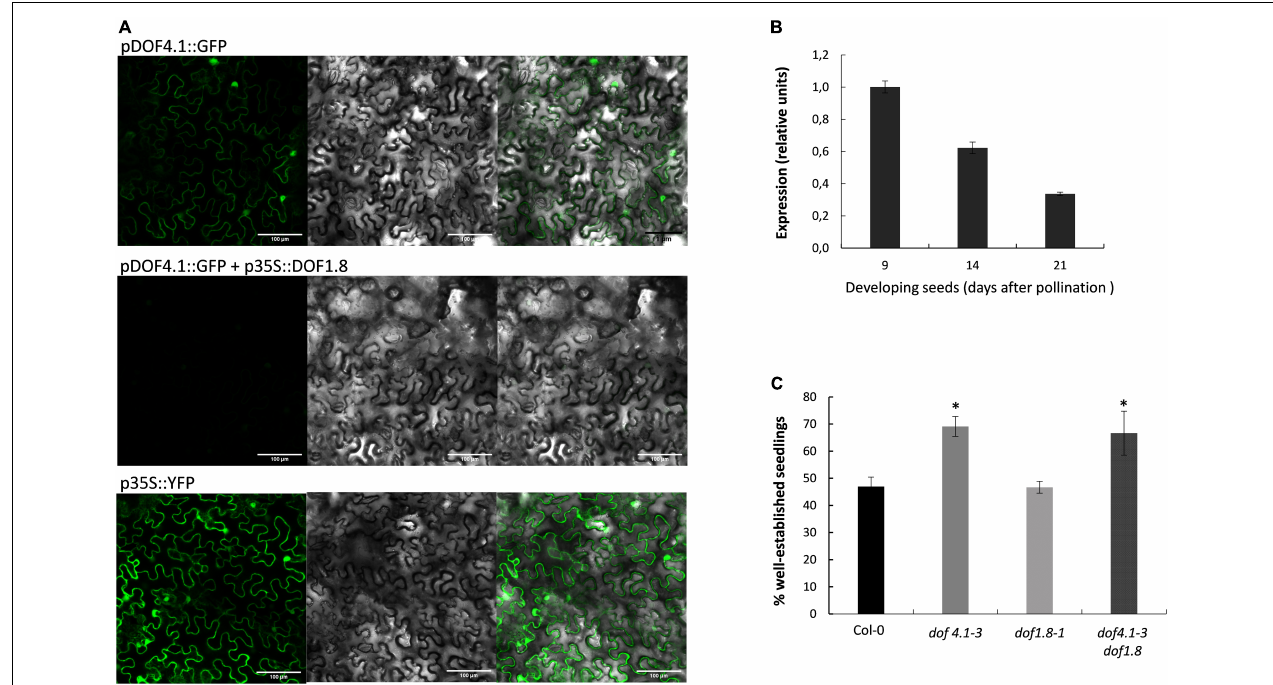
FIGURE 5 | DOF1.8 transcription factor represses DOF4.1. (A) Representative images showing the transient expression of pDOF4.1:GFP in Nicotiana benthamiana leaves 5 days after agroinfiltration in the absence (upper panel) or in the presence (middle panel) of p35S:DOF1.8 . The lower panel shows the expression of the positive control p35S: YFP. Scale bars 100 µ M. (B) Expression level of DOF1.8 was determined by qRT-PCR in developing seeds (9, 14, and 21 DAP). DAP, days after polinization. (C) Accelerated aging assay of dof1.8-1 mutant and dof4.1-3 dof1.8-1 double mutant. Seeds were imbibed in water and incubated at 40 ◦ C during 32 h. The percentage of established seedlings (with green cotyledons) was recorded after 9 days growing on MS media. Data are the mean and standard error of three biological replicates. Asterisks indicate significant differences with wild type ( P < 0.05) in two-tailed Student’s t -test. Col-0, Columbia